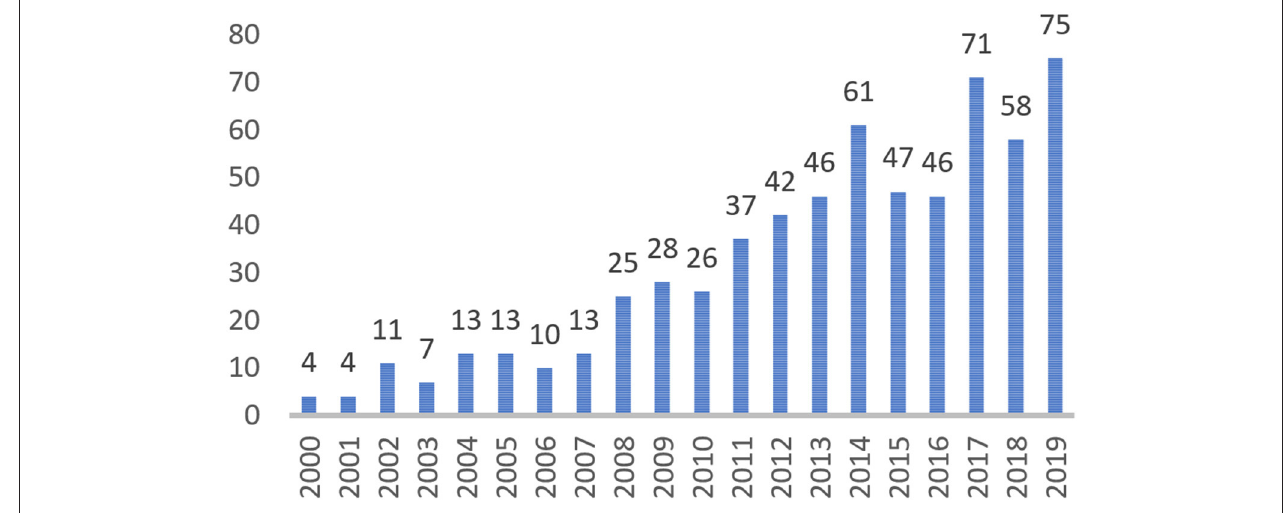
FIGURE 1 | Numbers of the articles on scaffolding from 2000 to 2019.